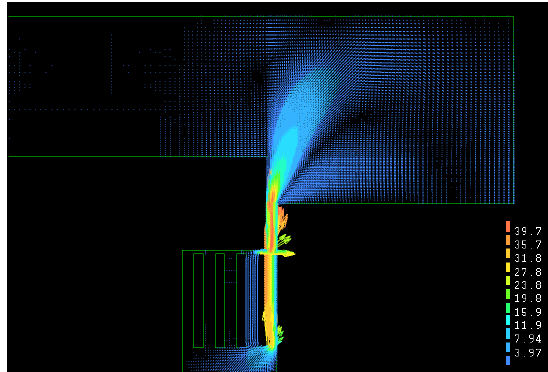
Fig. 8. Outcoming airflow in the plan when the upper edge of the side electrode being lower than that of the central electrode